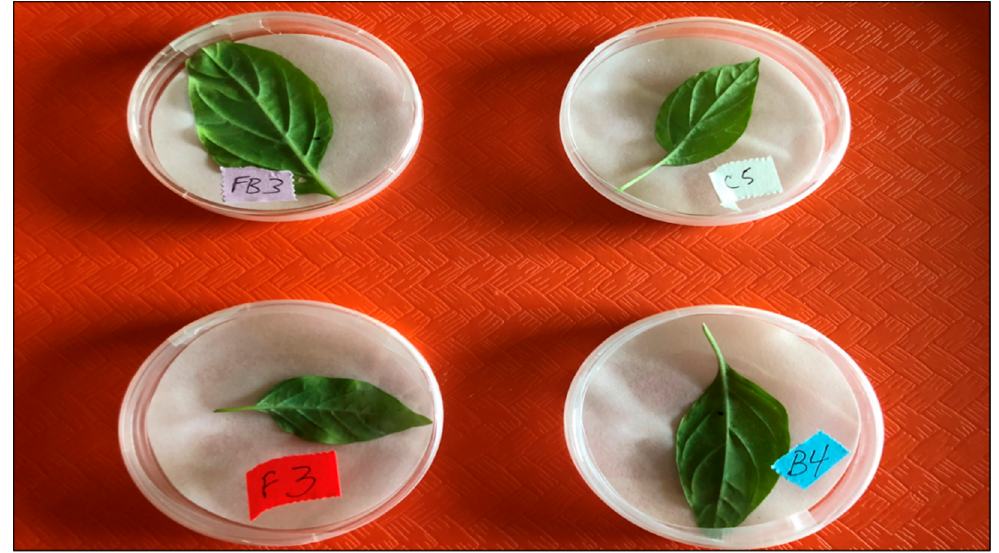
Figure 1. Bioassay experimental arena showing placement of treated detached leaves over moistened filter paper.